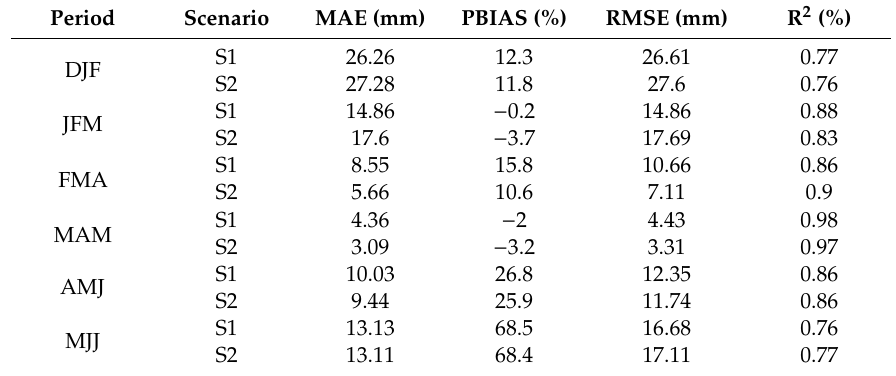
Table 9. Statistical and e ffi ciency indicators for the evaluation of prognostic performance in R5. Period Scenario